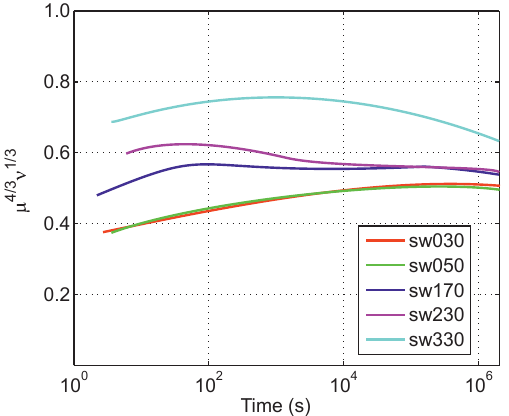
Figure 3. Evolution of the left-hand side of the invariant (Eq. 14) (µ 4 ν) 1 / 3 for runs of Table 1 (in the